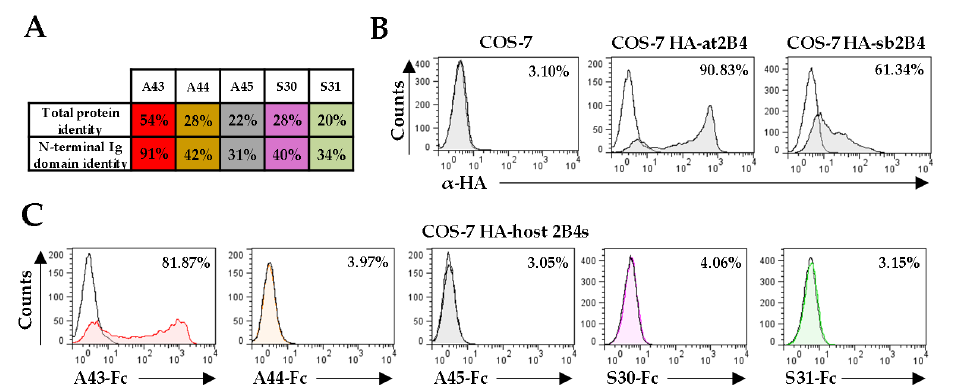
Figure 4. Analysis of the binding capacity of A44, A45, S30, and S31 to host 2B4. ( A ) Amino acid identity between each vCD48 and host CD48. The percent amino acid identity for the complete sequence or the N-terminal Ig domain sequence of each vCD48 compared to those of the corresponding host CD48 is shown. ( B ) Flow cytometry analysis of COS-7 cells non-transfected or transfected with HA-at2B4 or HA-sb2B4 and stained with α -HA mAb (shaded histograms) or an isotype control (open histograms). The percentage of positive cells is indicated in each histogram. ( C ) Interactions of vCD48s with host 2B4. COS-7 cells transfected with each host 2B4 as indicated in B were incubated with 8 µ g / mL of A43-Fc, A44-Fc, or A45-Fc in the case of HA-at2B4 transfected cells or S30-Fc and S31-Fc in the case of HA-sb2B4 transfected cells and then analyzed by flow cytometry (shaded and colored histograms). Open histograms represent isotype controls. The percentage of positive cells is indicated in each